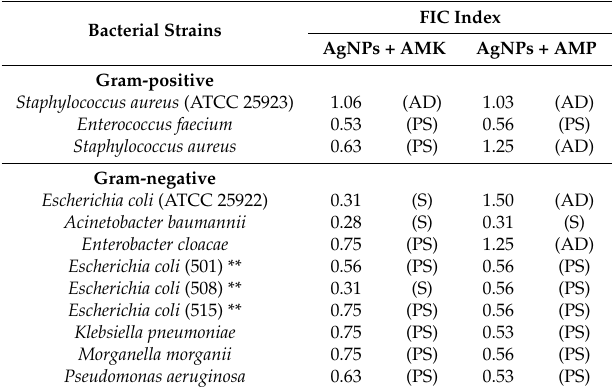
Table 3. FIC index of combinations among silver nanoparticles and antibiotics against clinical and reference